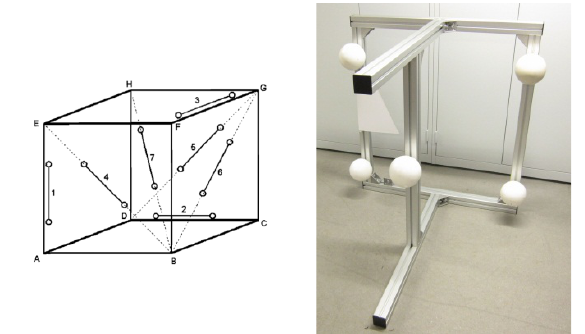
Figure 6. VDI 2634 suggestion for an ideal arrangement of test length in the measurement volume (left). Realized pyramidal structure with 10 test length